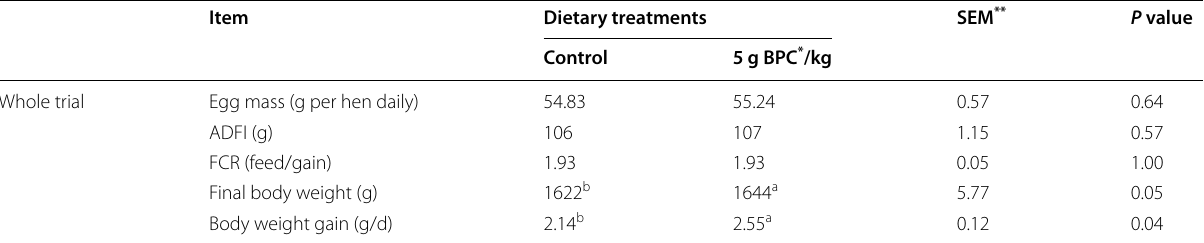
Table 4 Effect of cotton seed bioactive peptides supplementation on the body weight, food consumption, and food conversion efficiency of laying hens